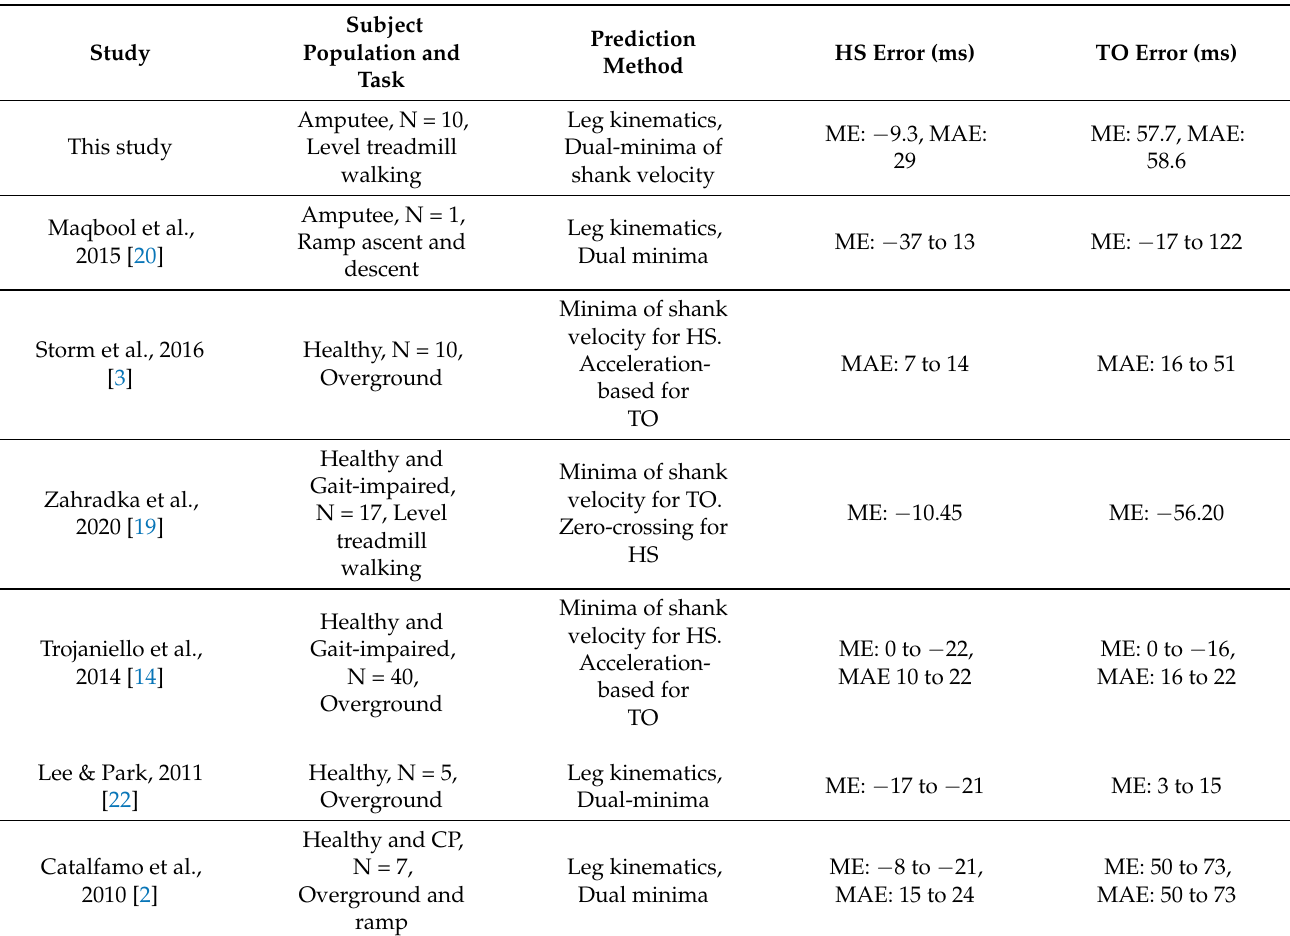
Table 2. A comparison with the error magnitudes found in this study and the available relevant literature, ME: Mean Error, MAE: Mean Absolute